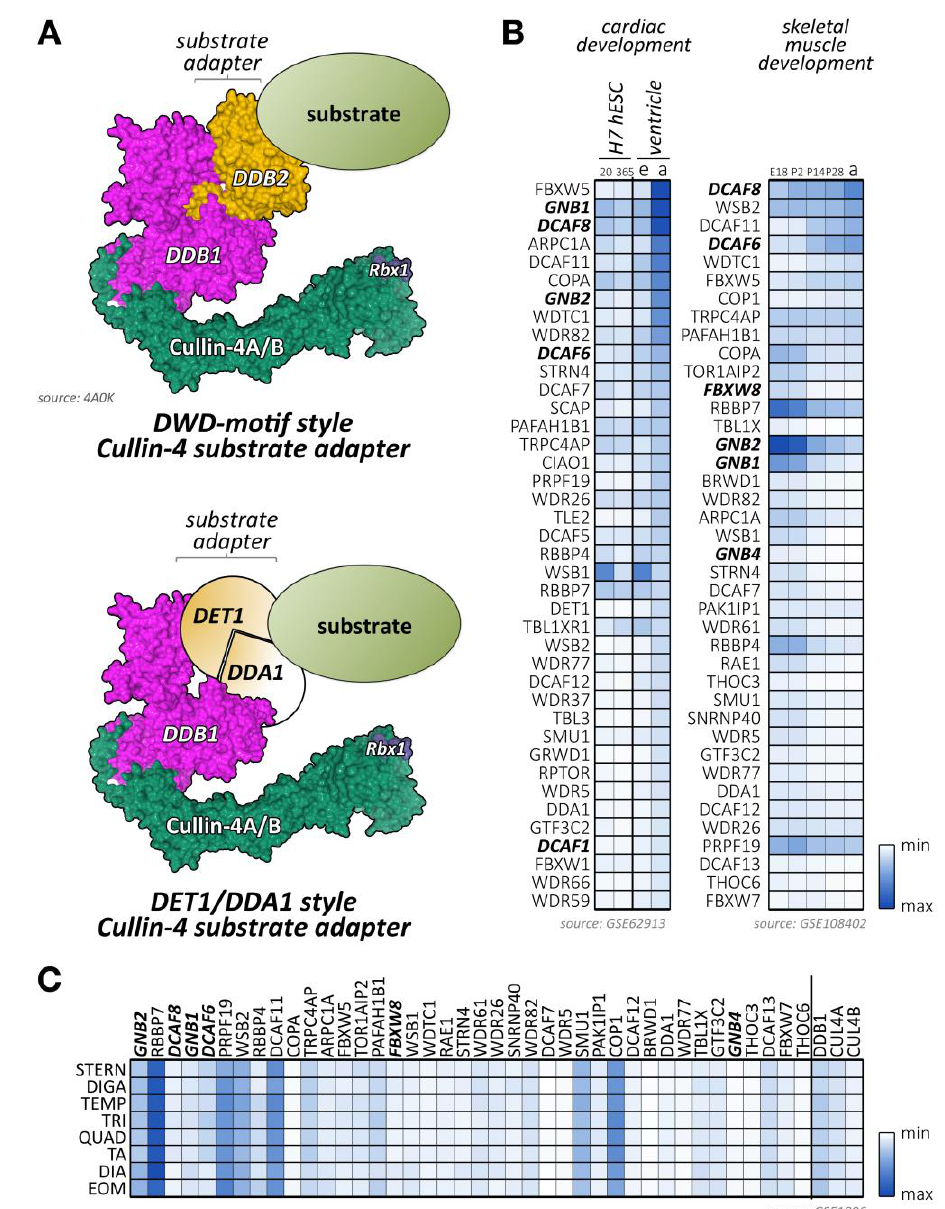
Figure 6. Substrate adapters for cullin-4A/4B-Ddb1 E3-ligases. ( A ) Complex organization of cullin-4A/B-based E3-ligases (surface representation from structure 4A0K [263]). Both cullin-4A/B scaffolds associate with the linker protein Ddb1 that binds to the various substrate adapter proteins. The most common adapters contain a DWD-motif mediating interaction with Ddb1 (top panel). Another adapter type is represented by the heterodimer of Det1 and Dda1 (bottom panel). ( B ) Heatmap analysis of known and suspected cullin-4A/B substrate adapter mRNA expression levels during cardiac development (differentiation of H7 human embryonic stem cells into cardiomyocytes at day 20 and day 365; as well as embryonic (e) or adult (a) mouse ventricular tissue; left panel) and skeletal muscle development (at embryonic day E18, and postnatal days 2, 14, 28 and adult stages; right panel). Data were adapted from GEO datasets GSE62913 and GSE108402 [91,92]. Adapter proteins with known functions for heart or skeletal muscles are highlighted in bold. ( C ) Muscle-type specific mRNA expression analysis of top 40 cullin-4A/B substrate adapters with known roles in cross-striated muscles, as well as the linker Ddb1, cullin-4A, cullin-4B itself. Analyzed adult muscles were sternomastoid (Stern), digastric (Diga), temporalis (Temp), triceps (Tri), quadriceps femoris (vastus lateralis; Quad), tibialis anterior (TA), diaphragm (Dia), and extraocular muscle (Eom). Data were adapted from GSE1806 [93].